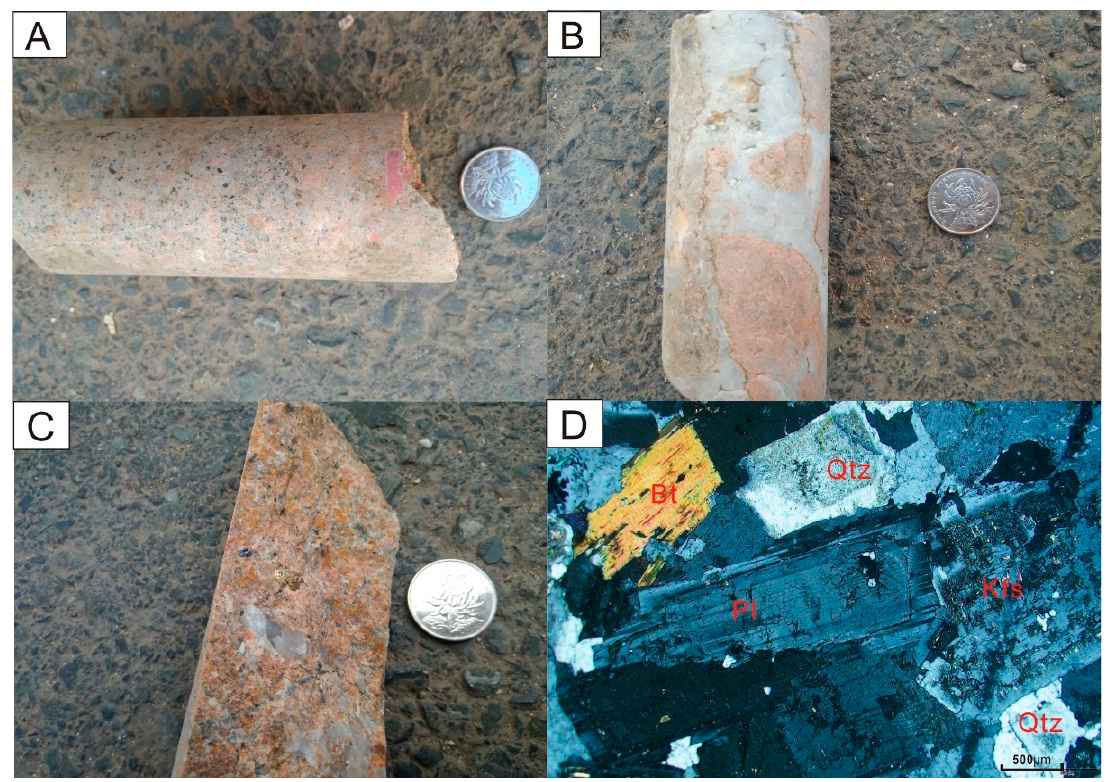
Figure 3. Microphotographs and photographs of monzogranite in the Chang’anpu area. ( A ) monzogranite (hand specimen); ( B ) brecciated monzogranite (hand specimen); ( C ) photomicrograph of monzogranite adjacent to the ore body; ( D ) photomicrograph of monzogranite (cross-polarized light). Abbreviations: Qtz—quartz; Pl—plagioclase; Bt—biotite; Kfs—potash feldspar.